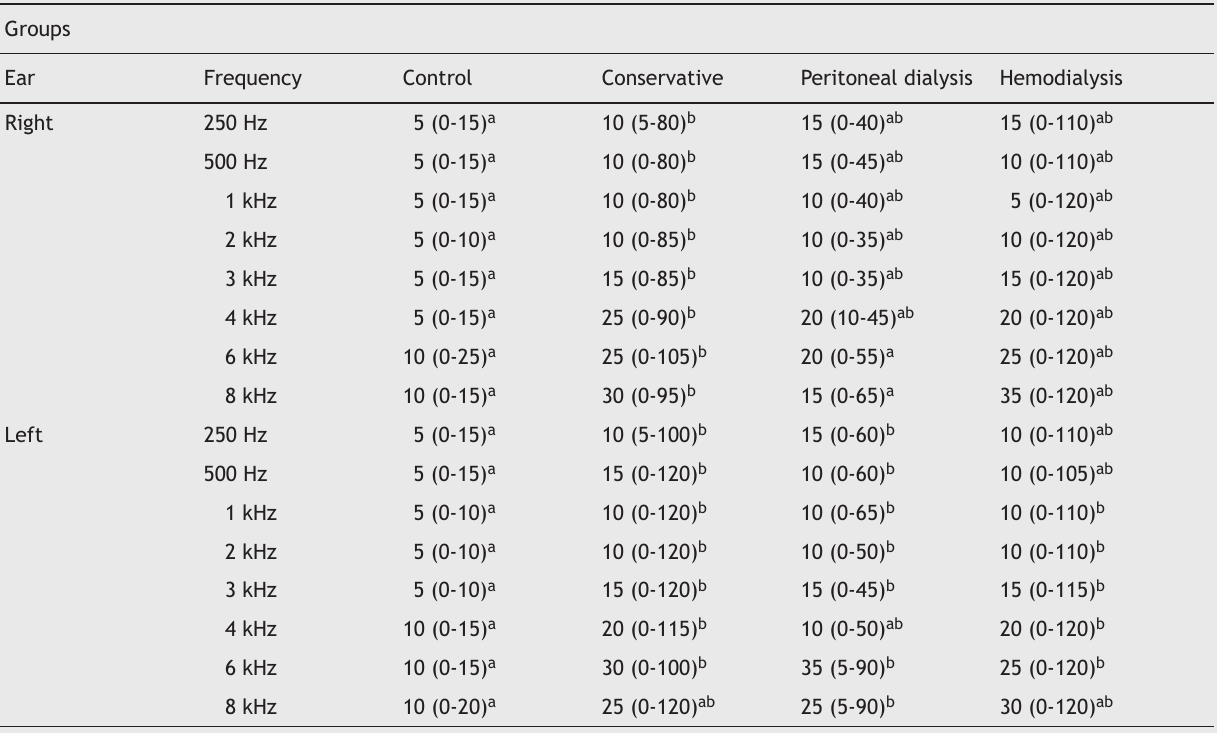
Table 2 Comparison of hearing thresholds at frequencies of 250 Hz to 8 kHz assessed by pure-tone audiometry in each ear according to group.